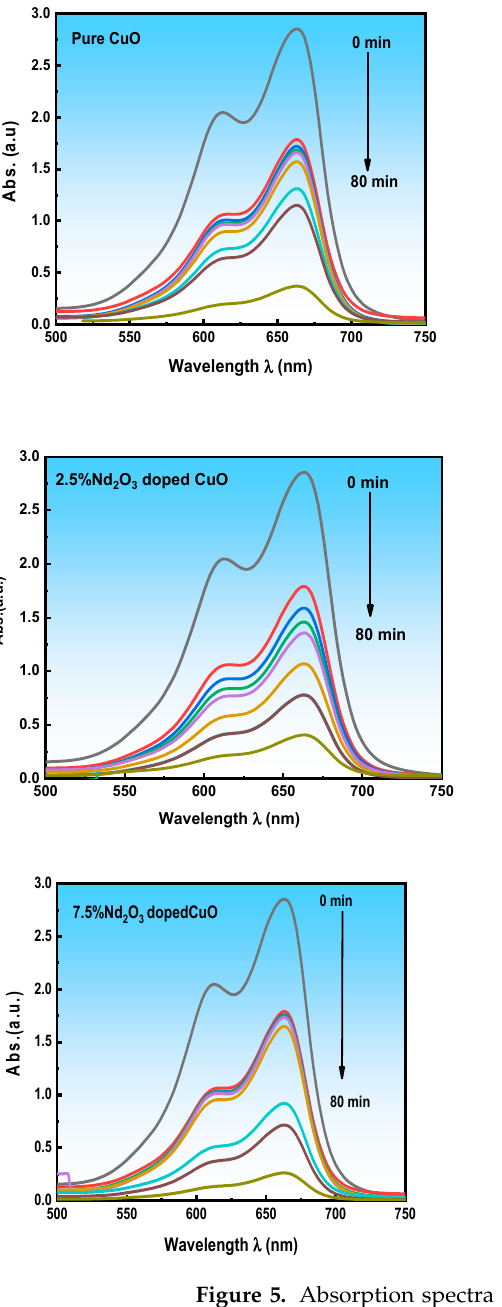
90.8% within 80 min under visible light irradiation. The rate of MB degradation k (min − 1 ) was achieved by [24]: